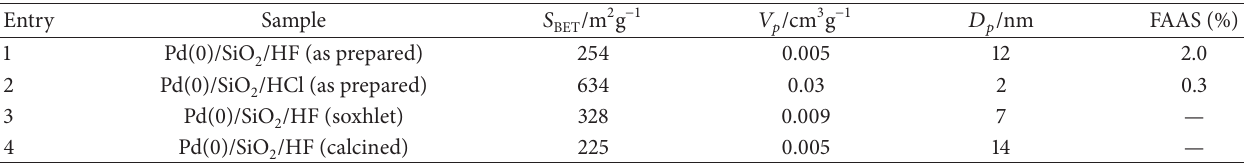
Table 1: Textural properties of the xerogel a .